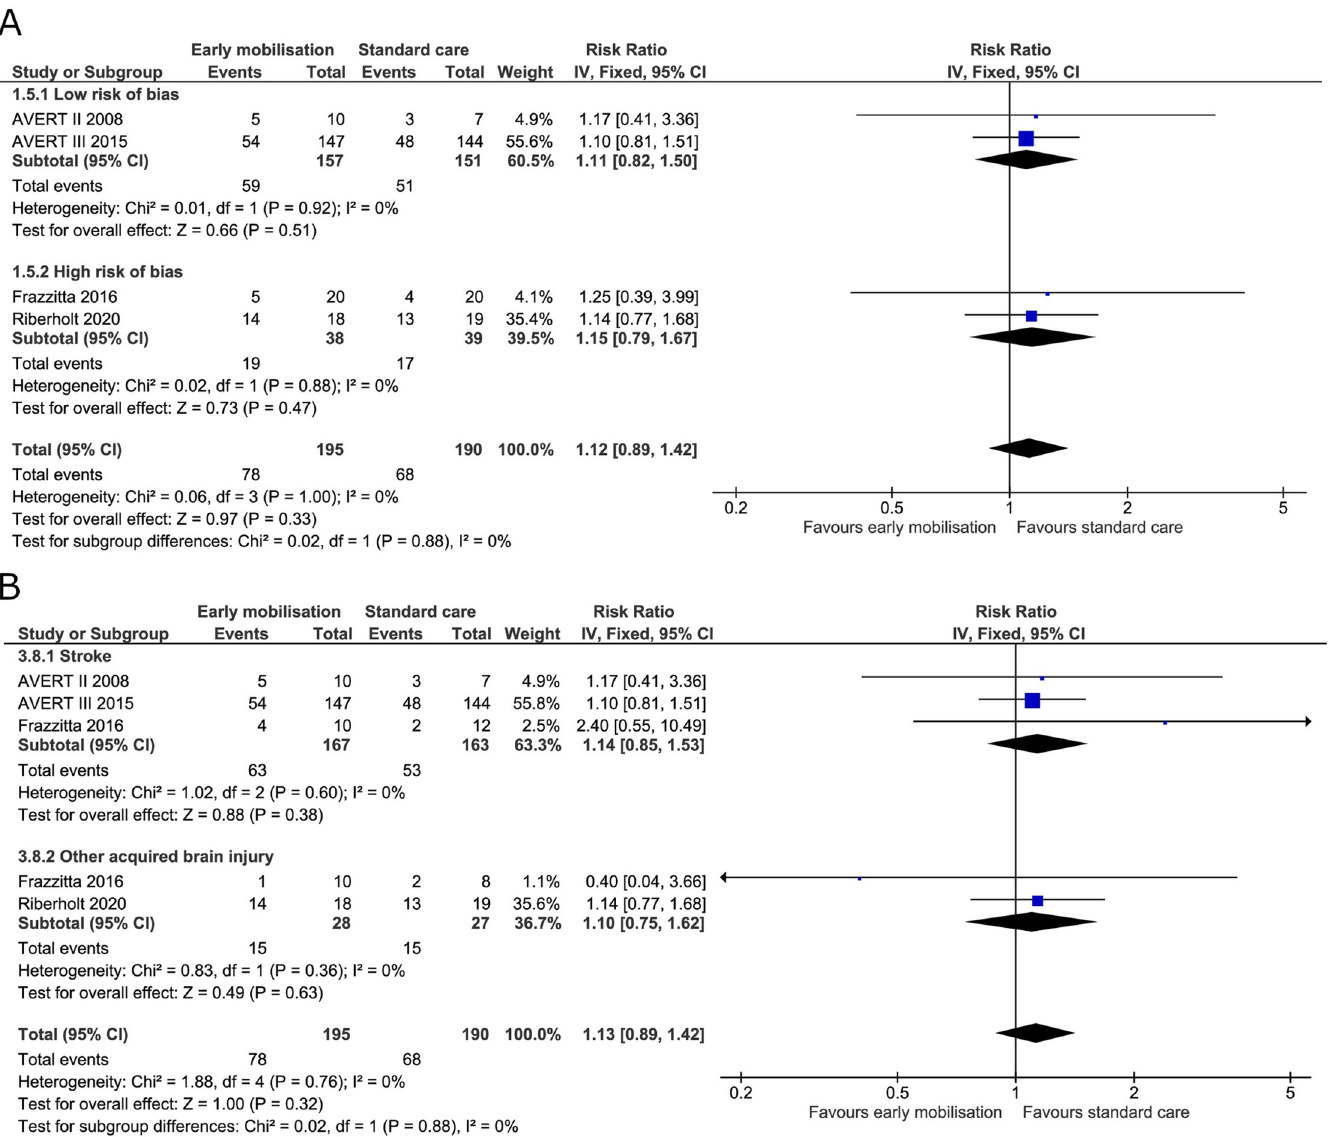
Fig 11. Comparison of early mobilisation versus standard care–Serious adverse events at the end of the intervention. Fig 11 A and B. Forest-plots showing the results from the fixed-effect meta-analysis of the outcome serious adverse events at the end of intervention with subgroup divided according to risk of bias (A) or diagnosis